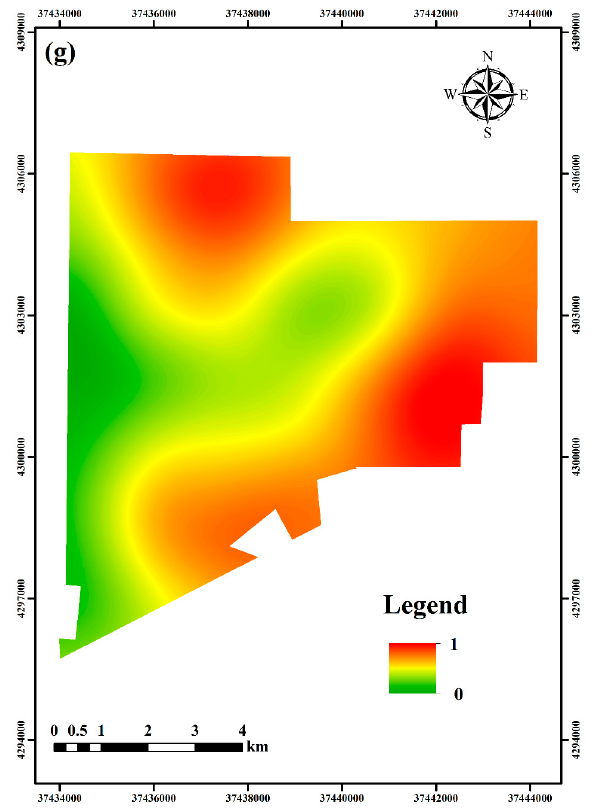
Figure 7. The dimensionless thematic map for the evaluation criteria: ( a ) T1; ( b ) T2; ( c ) T3; ( d ) T4; ( e ) T5; ( f ) T6; ( g ) T7.